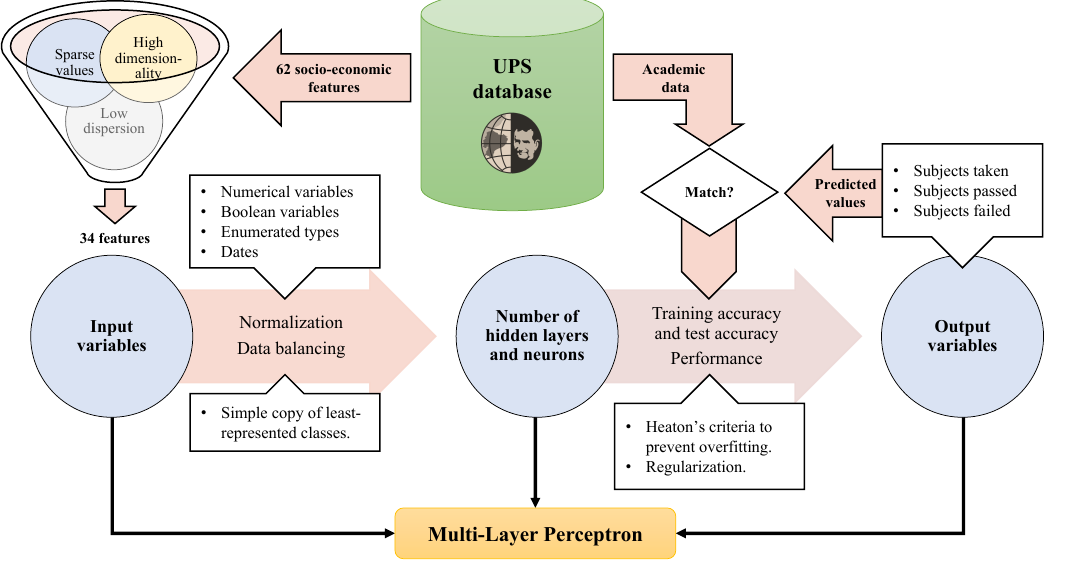
Figure 1. Key concepts, tasks and data flows of our